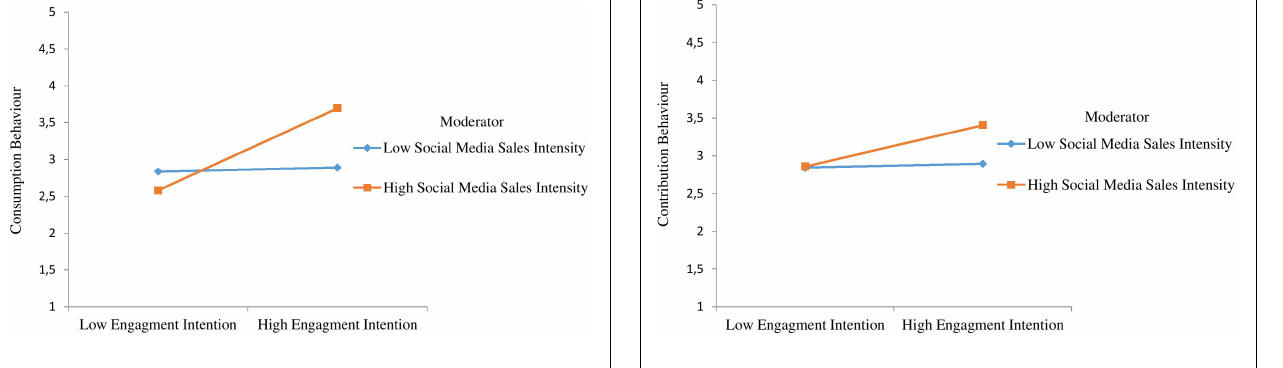
FIGURE 4 | Interactive effects of engagement intention and social media sales intensity on contribution